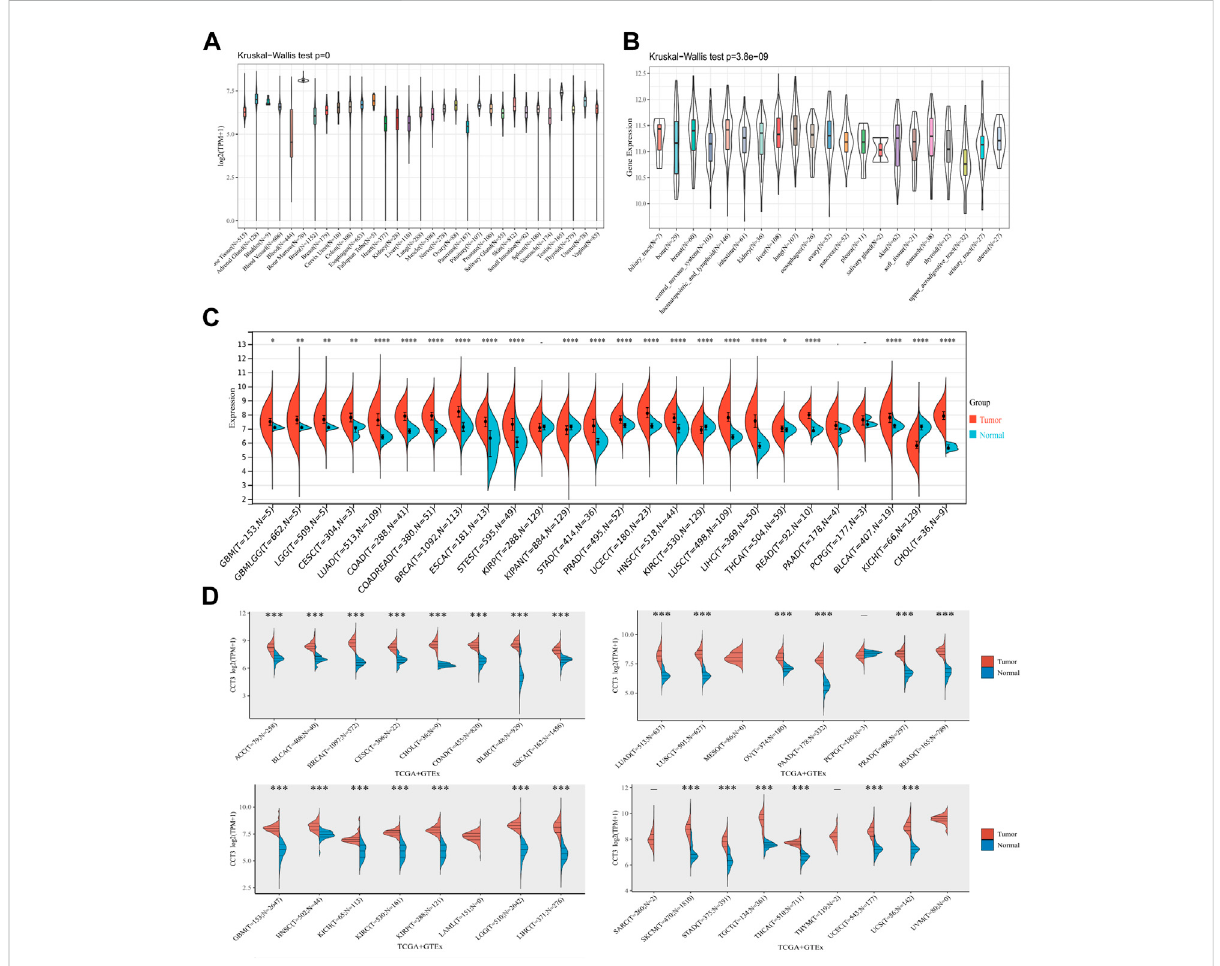
Expression levels of CCT3 in pan-cancer. (A) The expression levels of CCT3 in normal tissues were analyzed using the GTEx datasets. (B) The expression levels of CCT3 in different tumor tissues were analyzed using the CCLE datasets. (C) Differential expression levels of CCT3 in tumor and correspondingnormaltissueswereanalyzedusingtheTCGAdatasets. (D) DifferentialexpressionlevelsofCCT3intumorandcorrespondingnormal tissues were analyzed using the TCGA and GETx datasets. * p < 0.05, ** p < 0.01, *** p <